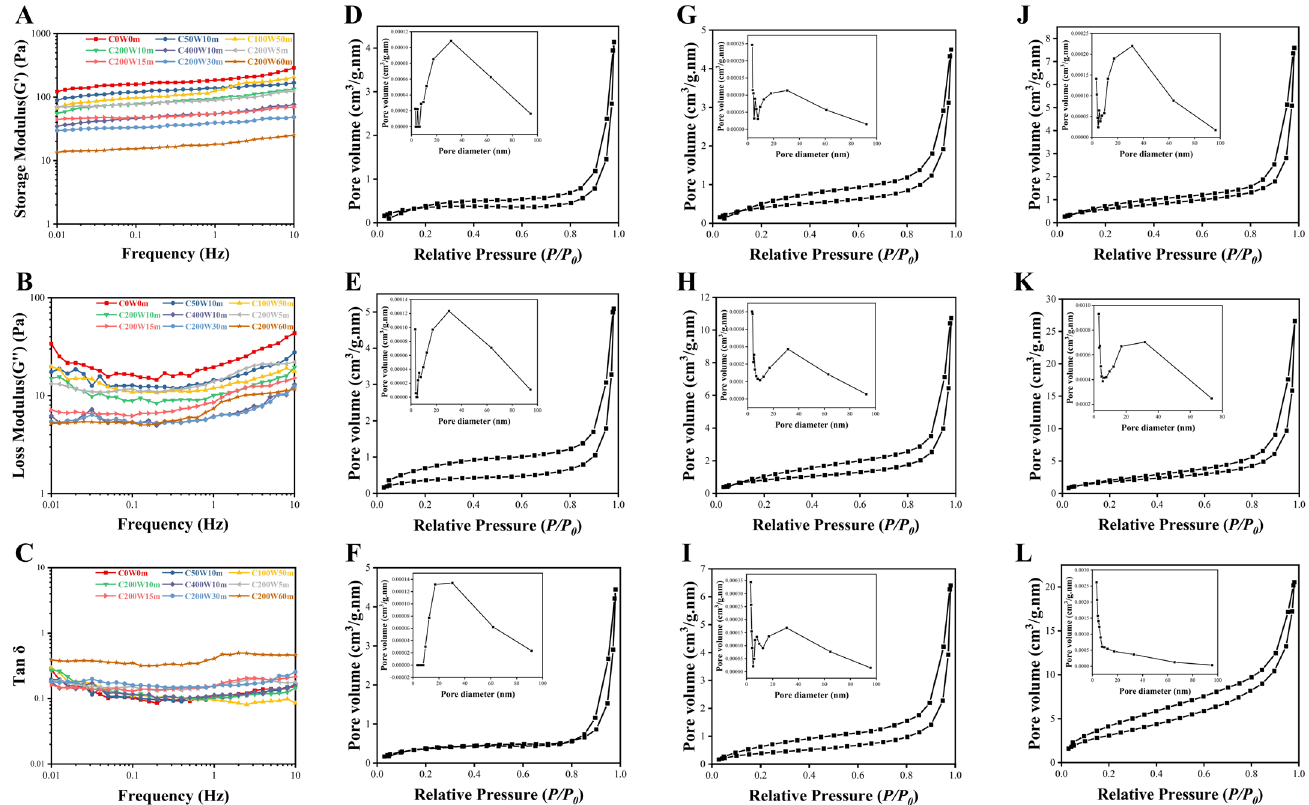
Figure 6. Storage modulus (G′), ( A ), loss modulus (G′′), ( B ) and loss tangent (tan δ), ( C ) of collagen fibril gels; N 2 adsorption isotherms and BJH pore size distribution curves of C0W0m ( D ), C50W10m ( E ), C100W10m ( F ), C200W10m ( G ), C400W10m ( H ), C200W5m ( I ), C200W15m ( J ), C200W30m ( K ) and C200W60m ( L ).